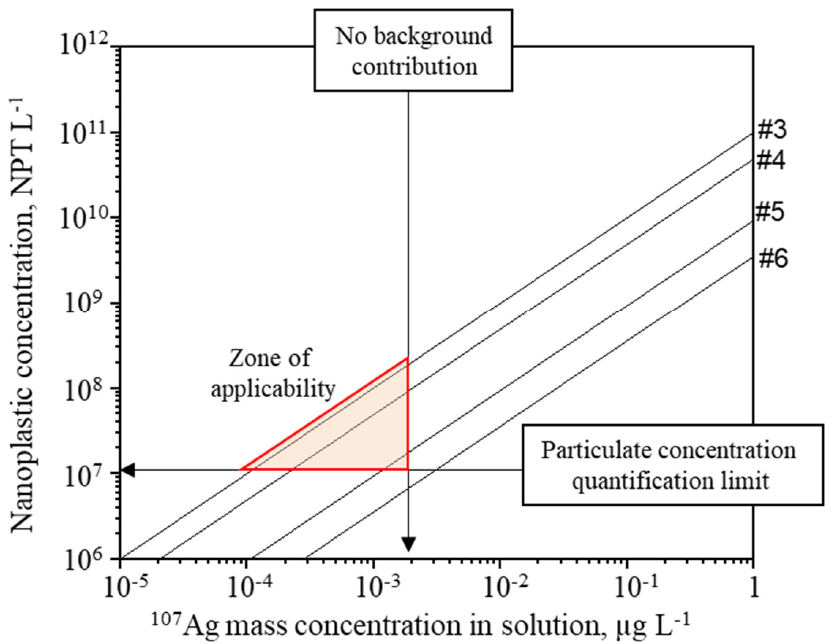
Figure 3. Theoretical silver concentration for the different experiments if no modification of Qe oc- Qe curs.